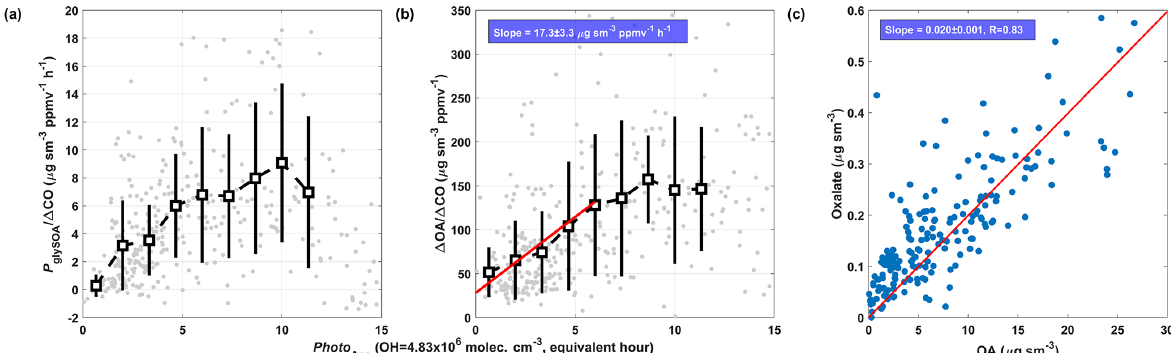
Figure 6. Photochemical age (Photo age ) dependence of dilution corrected (normalized by CO enhancement) (a) P glySOA and (b) OA enhancement over SMA. The square markers and bars are the mean ± 1 σ standard variation. Normal regression (shown as red line in b ) was used to fit the early photochemical state data (Photo age < 6h). Panel (c) shows the relation between oxalate OA and ODR